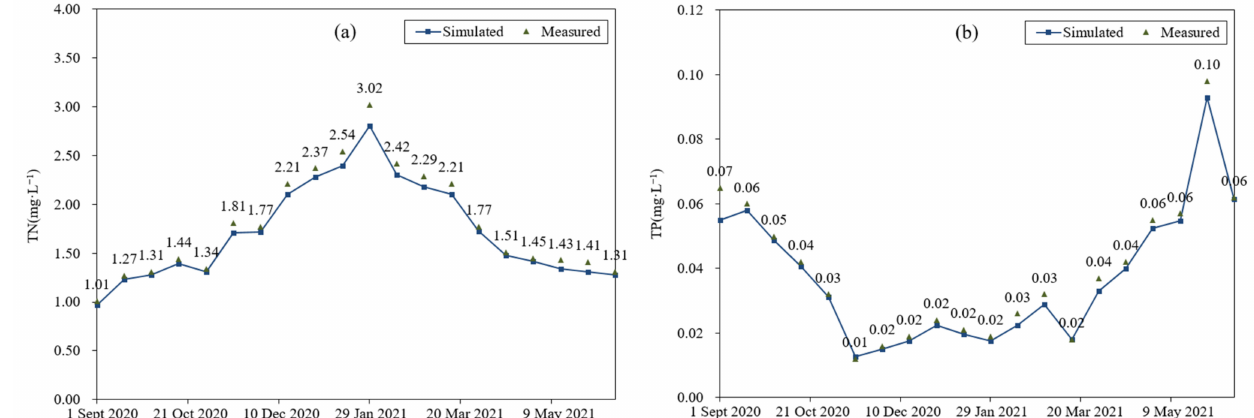
Figure 6. Measured and simulated TN ( a ) and TP ( b ) in the Yujiang River.